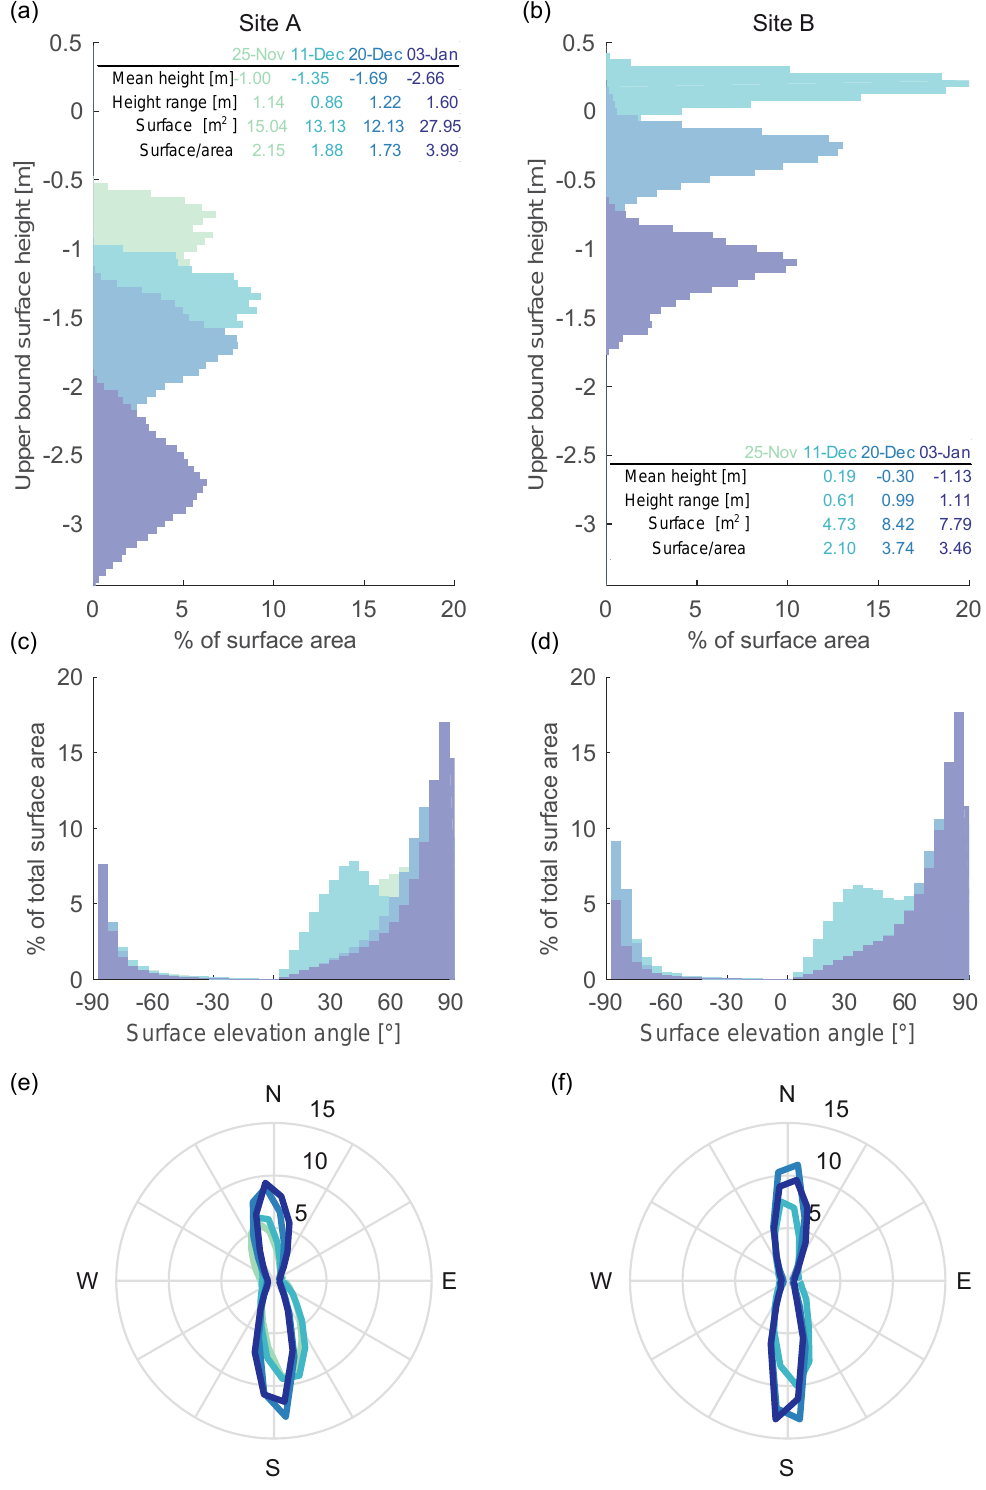
Figure 4. Summary of the DSM properties through time at sites A (left) and B (right). (a, b) Surface height distribution as a percentage of total surface area, in local coordinates (m) relative to the position of the northern end of ablation frame. Inset tables show weighted mean mesh elevation, range, surface area and surface area as a function of the horizontal area of the sampled site. (c, d) Distribution of surface angles as a percentage of total surface area. (e, f) Aspect distribution as a percentage of total surface area.